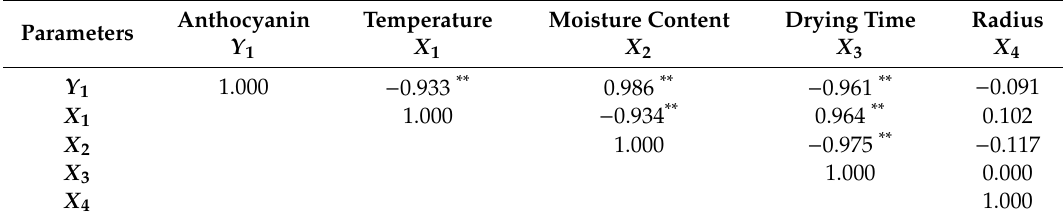
Table 2. The correlation coe ffi cients of the influencing factors on anthocyanin content. Parameters